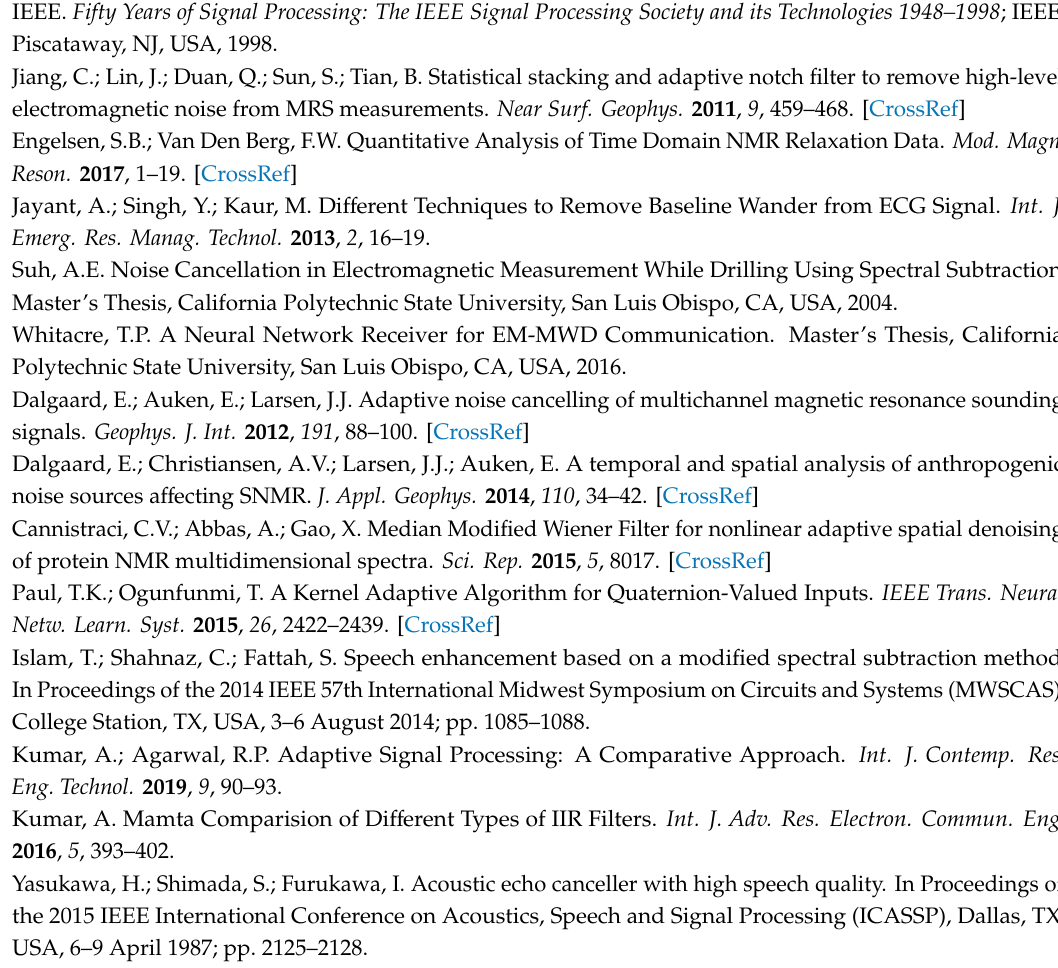
Figure A5. EM telemetry noise characteristics for dipoles L4, L5 and L7 orthogonal to the main signal: ( a ) frequency spectrum of measured noisy data and ( b ) frequency spectrum of recorded data for the frequency range of interest.